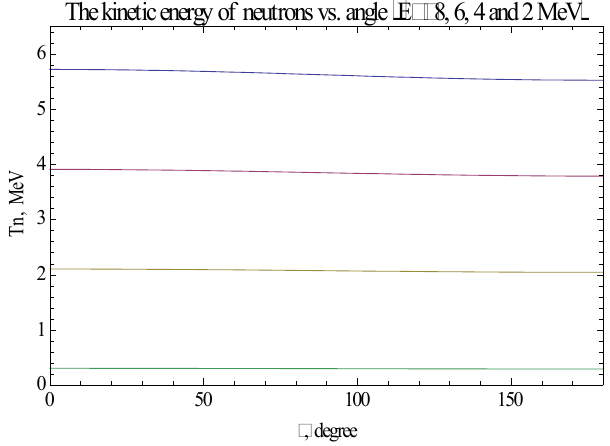
Fig. 6. The angle dependence of kinetic energy of outgoing neutrons for reaction γ + 9 Be → n + 8 Be at energy E γ =8, 6, 4 and 2 MeV (violet, red, yellow, and green line respectively).